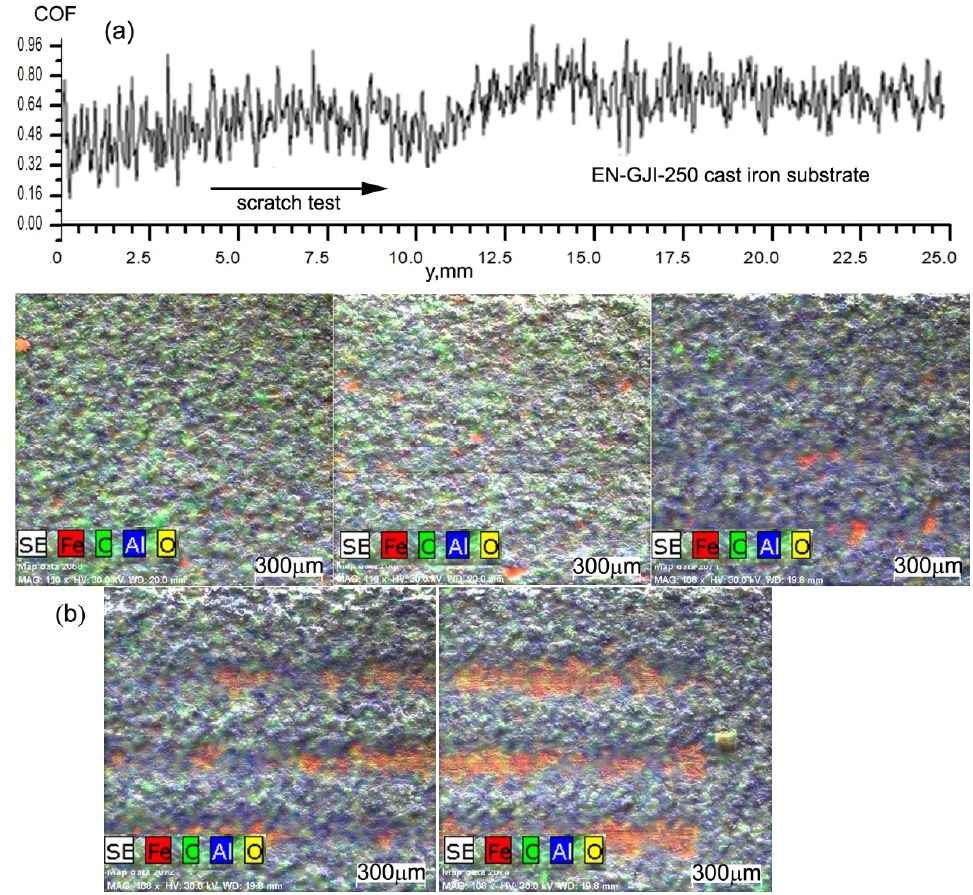
Figure 5. Analysis of the scratching test using the coefficient of friction behaviour: ( a ) variation of coefficient of friction on 25 mm distance; ( b ) distribution of elements Fe, C, Al and O on the surface of the scratched ceramic coating.